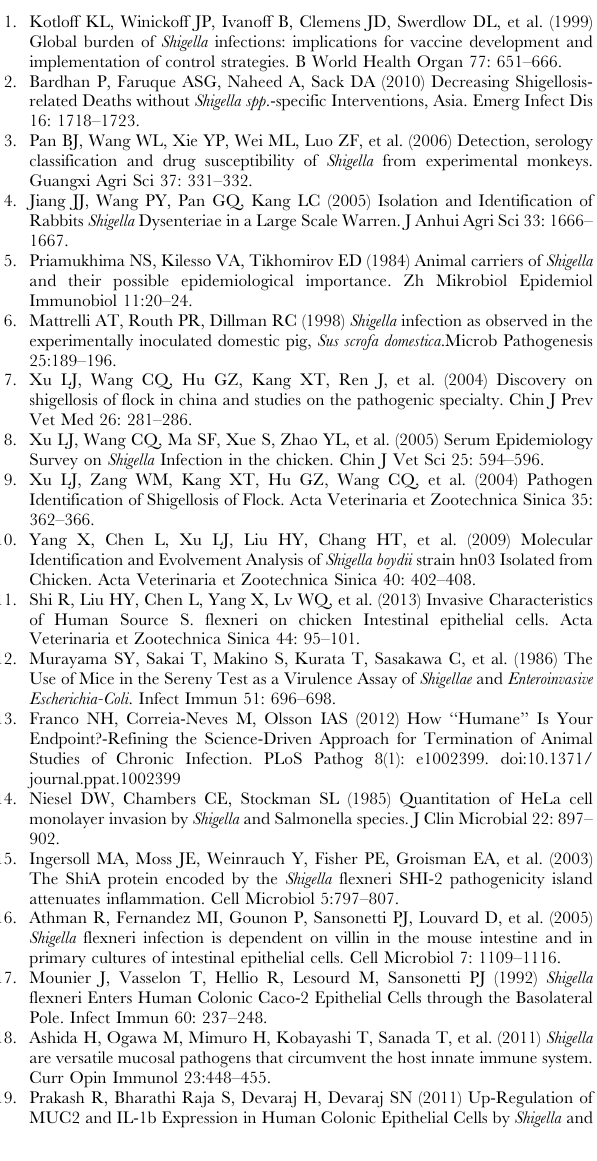
panel). Table S1 Detailed information of chicken infected with Shigella strain ZD02 via intraperitoneal or crop injec- tion. Table S2 Detailed incidence and mortality of three-day- old SPF chickens infected with the Shigella strain ZD02 via intraperitoneal injection. The LD 50 of Shigella infection via intraperitoneal injection in the three-day-old chickens was 1.19 6 10 8 CFU using the Reed-Muench